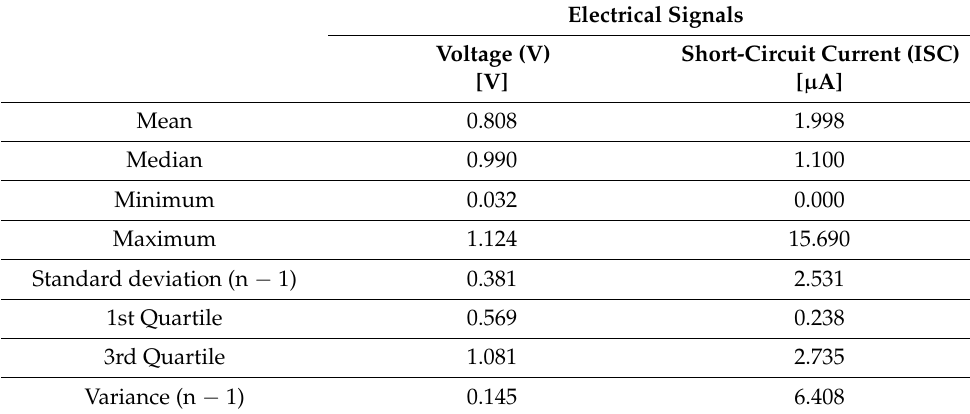
Table 3 present the total results obtained for the electric signal measurements: voltage (V) and short-circuit current (ISC). Both V and ISC present much higher variations than the moisture measurements. So, V has an average value of V = 0.808 V with very high standard deviation (std = ± 0.381 V) and variance. The same heterogeneous behaviour present ISC with an average value of ISC = 1.998 mA and std = ± 2.531 mA. Table 3. Descriptive statistics for the results of voltage (V) and short-circuit current (ISC) from 240 samples measured in 24 weeks from late spring to early autumn 2021. Electrical Signals Voltage (V)